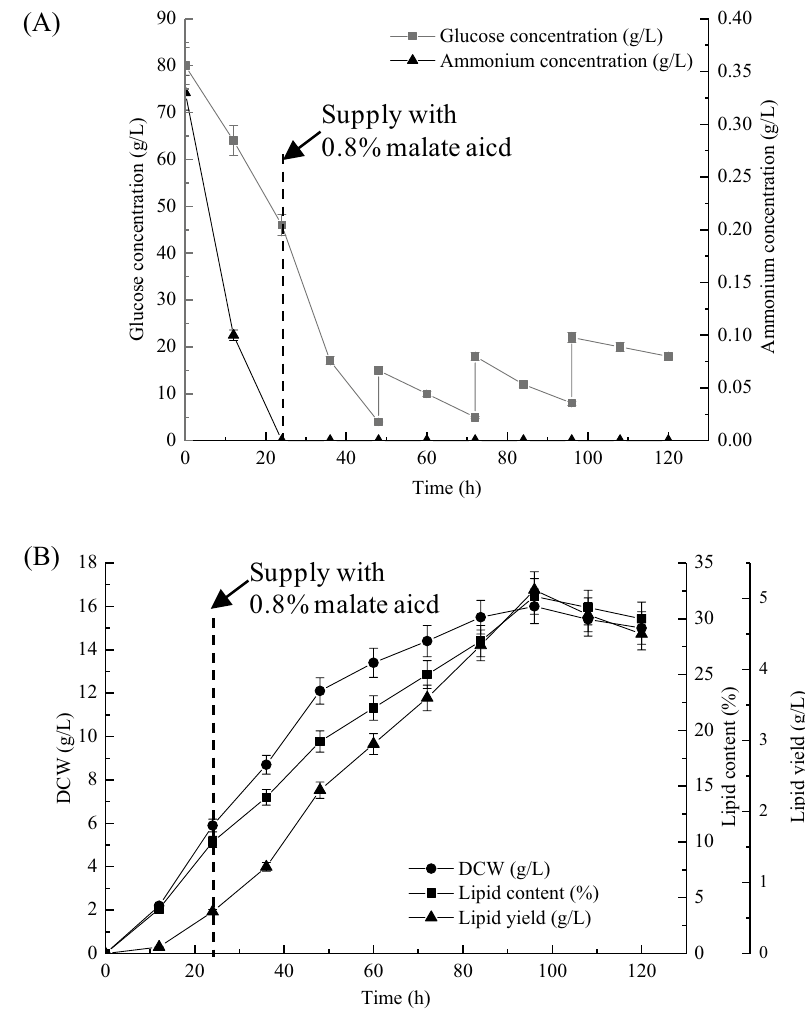
Figure 4. Fed-batch culture of Mc-MT-2 with a glucose feeding strategy and supplementation of malic acid. Residual glucose and ammonium concentration ( A ), cell dry weight, lipid content and lipid yield ( B ) were determined every 12 h in the fermentation process. Values were mean of three independent fermentation experiments. Error bars represent the standard error of the mean.